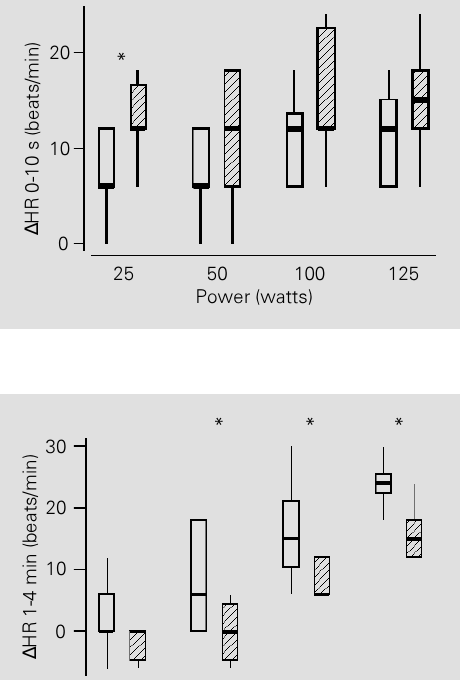
Figure 3 - Increases in HR ( D HR) during dynamic exercise at power values of 25, 50, 100 and 125 watts, in the 0-4-min inter- val ( D 0-4 min) in the sedentary (open boxes, N = 7) and trained (hatched boxes, N = 8) groups. The data are reported as medi- ans, quartiles (1st and 3rd) and minimum and maximum values.